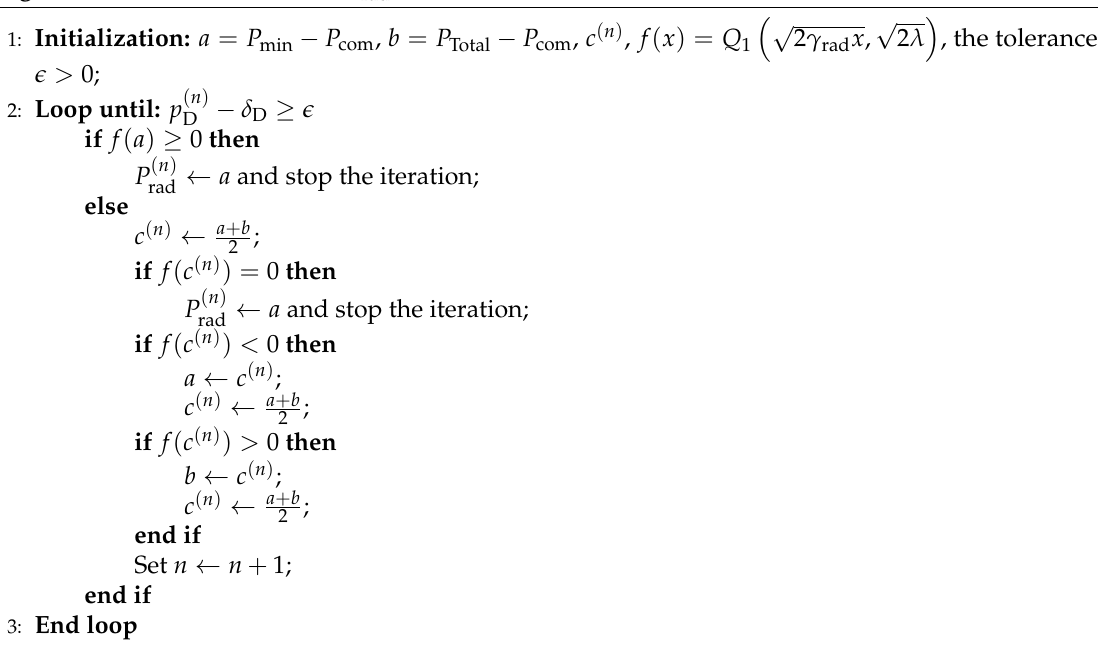
Algorithm 2 Bisection Search of P